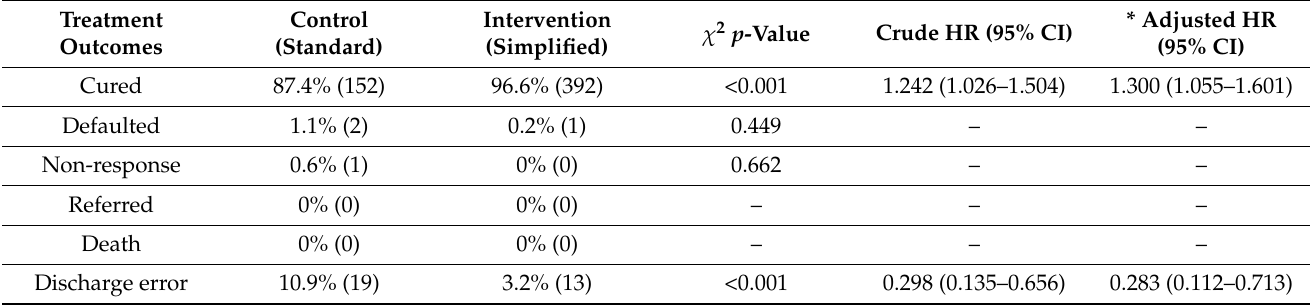
Table 4. Discharge outcomes compared by study group.